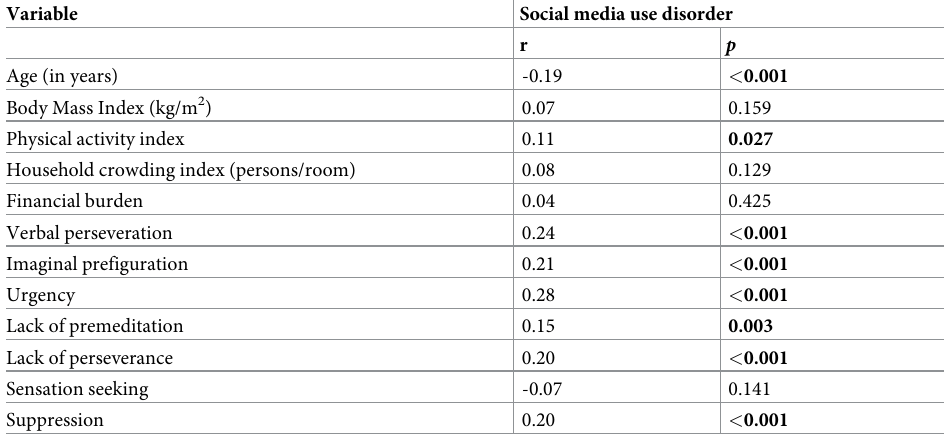
Table 4. Correlation of continuous variables associated with social media use disorder.